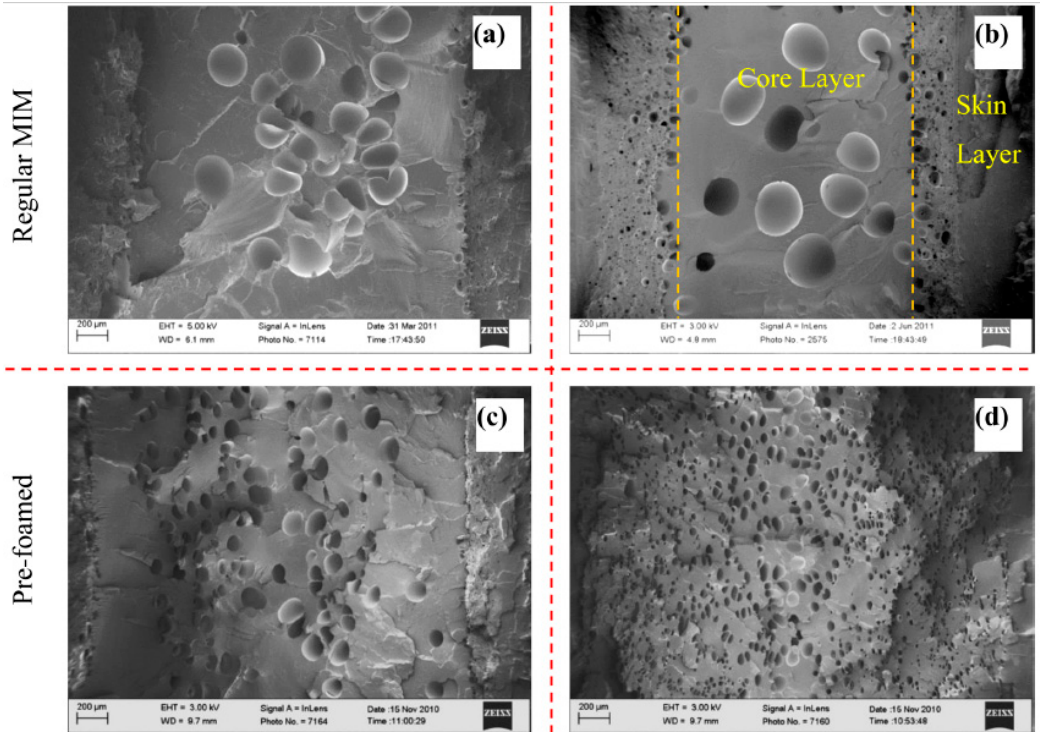
Figure 27. Cellular structures of (100× magnification): ( a ) neat PLA foam without pre-foaming, ( b ) PLA/clay foam without pre-foaming, ( c ) neat PLA foam with pre-foaming, and ( d ) PLA/clay foam with pre-foaming. Reprinted from Zhao et al. [90]. Copyright (2020) American Chemical Society.